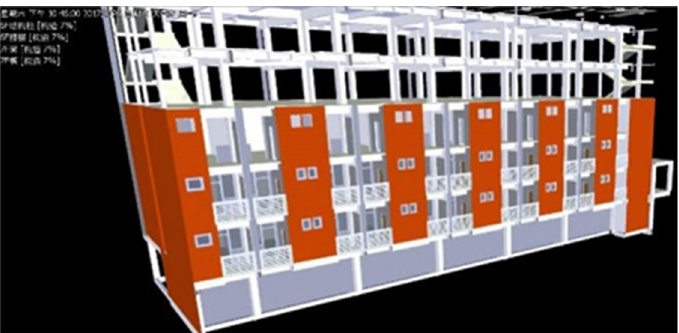
Figure 16. Progress of the project in week 8.